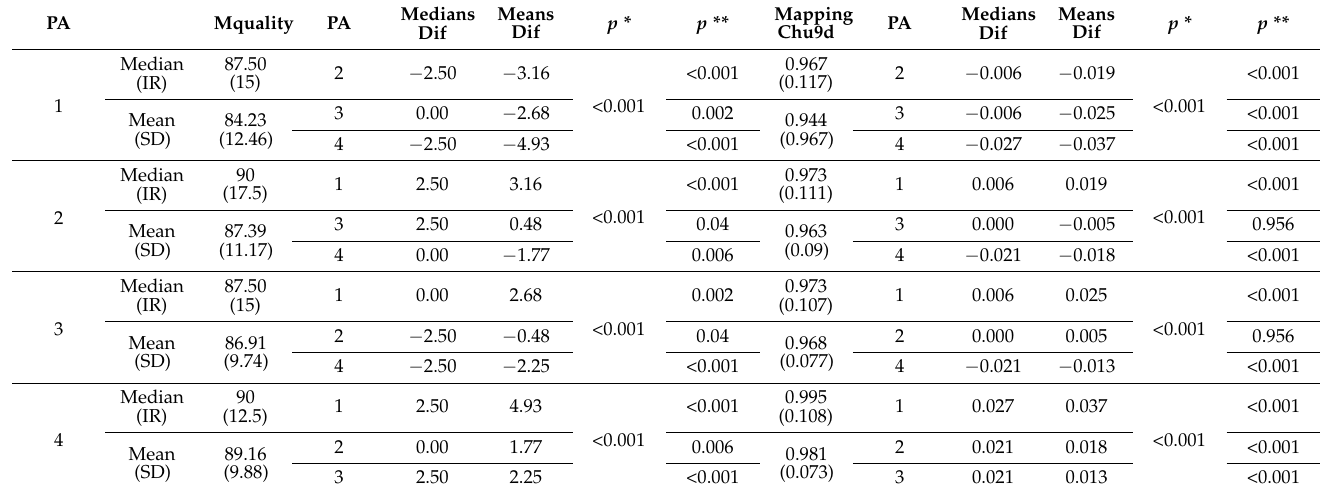
Table 2. Relationship between HRQoL and PA practice frequency.